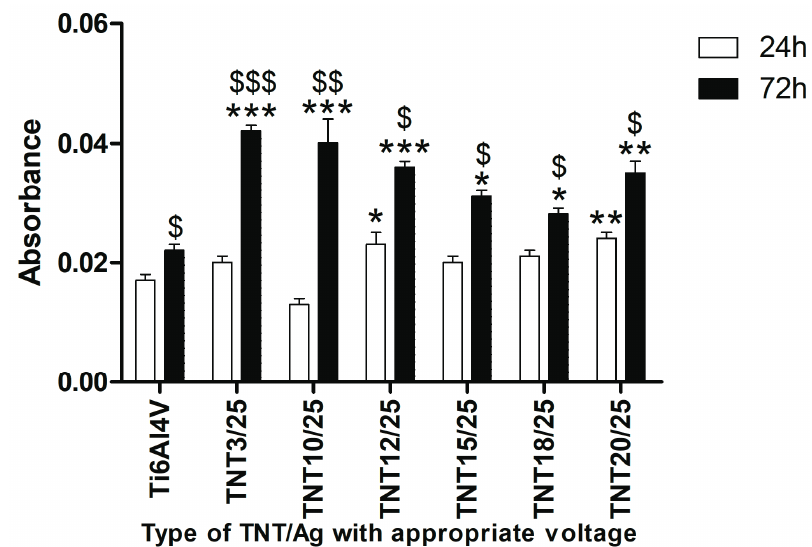
Figure 5. Effect of TiO 2 nanotubes coatings enriched with silver nanoparticles in PEALD process with 25 cycles on the murine fibroblasts L929 adhesion (after 24 h) and proliferation (after 72 h) detected by MTT assay. The absorbance values are expressed as means ± SEM of three independent experiments. Asterisks indicate significant differences between the fibroblasts incubated with Ti6Al4V alloy references sample (Ti6Al4V) compared to the tested TNT/Ag at appropriated incubation time (* p < 0.05, ** p < 0.01, *** p < 0.001, respectively). $ marks denote significant differences between the cells incubated with TNT/Ag for 24 h compared to 72-h incubation time ( $ p < 0.05, $$ p < 0.01, $$$ p < 0.001, respectively).